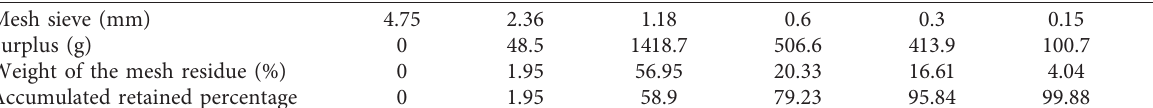
Table 2: Grain grading of coral sand (wt.%).